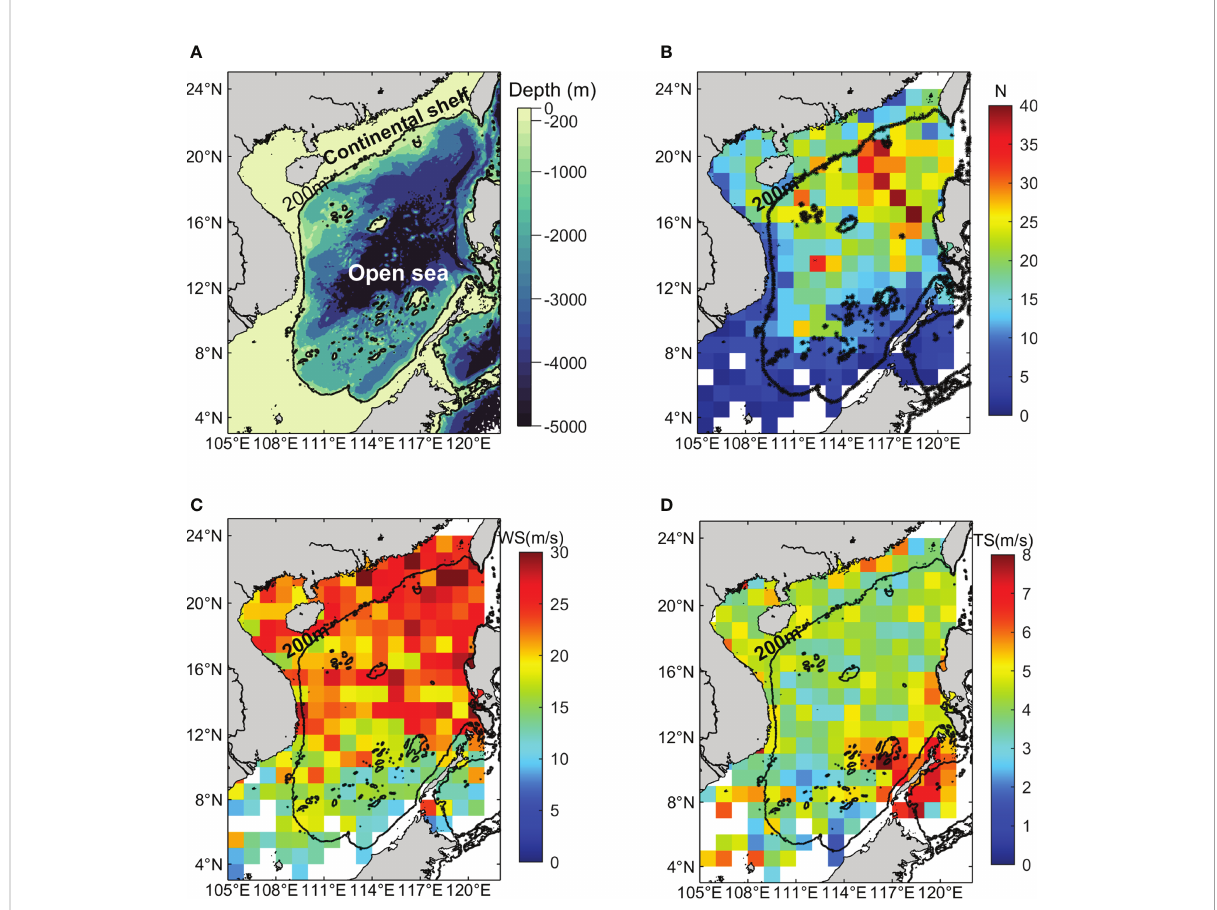
FIGURE 1 (A) Topography of the South China Sea basin (extrapolated from ETOPO1 gridded bathymetry data). The black contour represents the 200-m isobath; (B-D) Geographic distribution of the number of TC track points, mean TC wind speed and mean TC translation speed in the SCS between 1998 and 2020. The TC number is de fi ned as the number of all identi fi ed TC track points in each 1°×1°